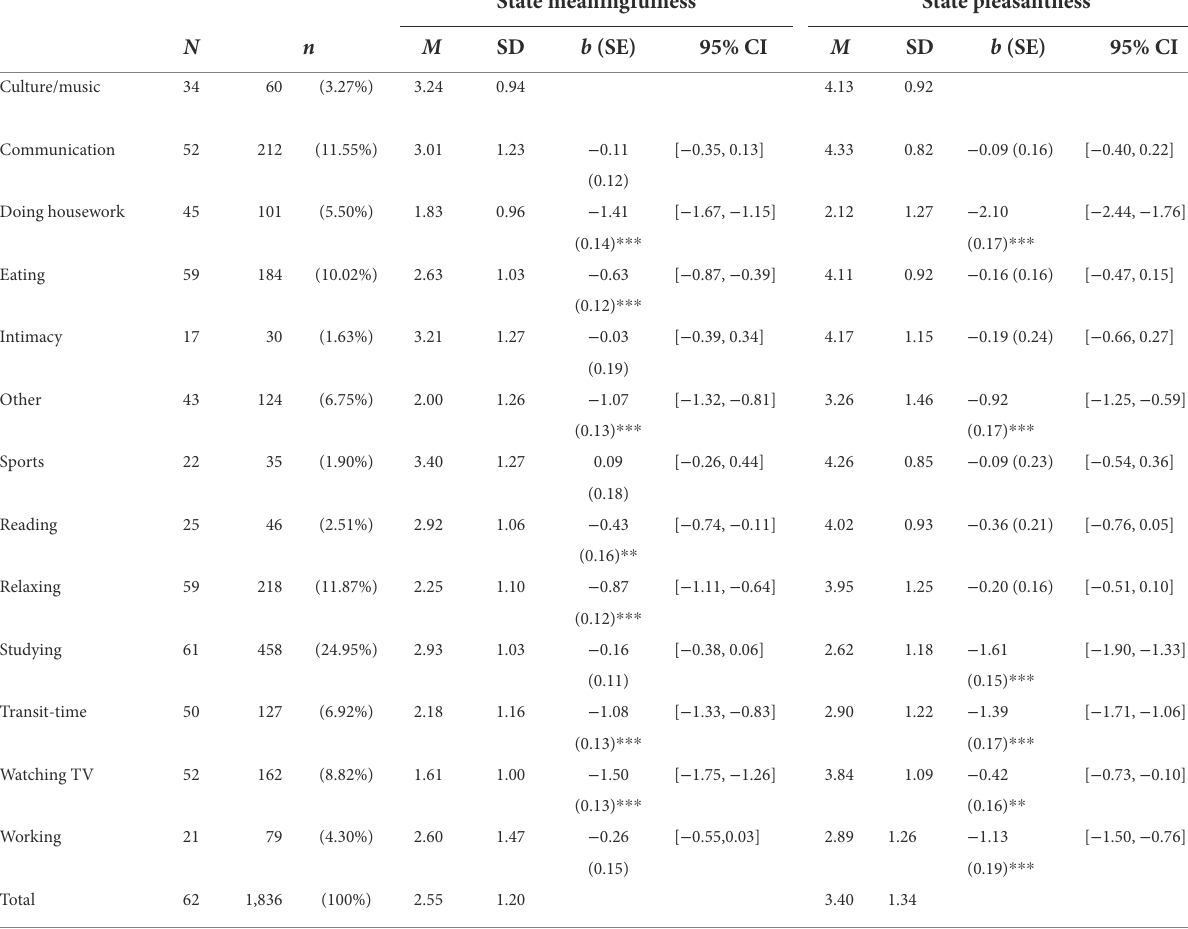
TABLE 4 Descriptive statistics of state meaningfulness and state pleasantness across daily activities and results of the two two-level hierarchical linear regressions with the outcome variables state meaningfulness and state pleasantness predicted by daily activities, all at level 1, nested in persons at level 2.